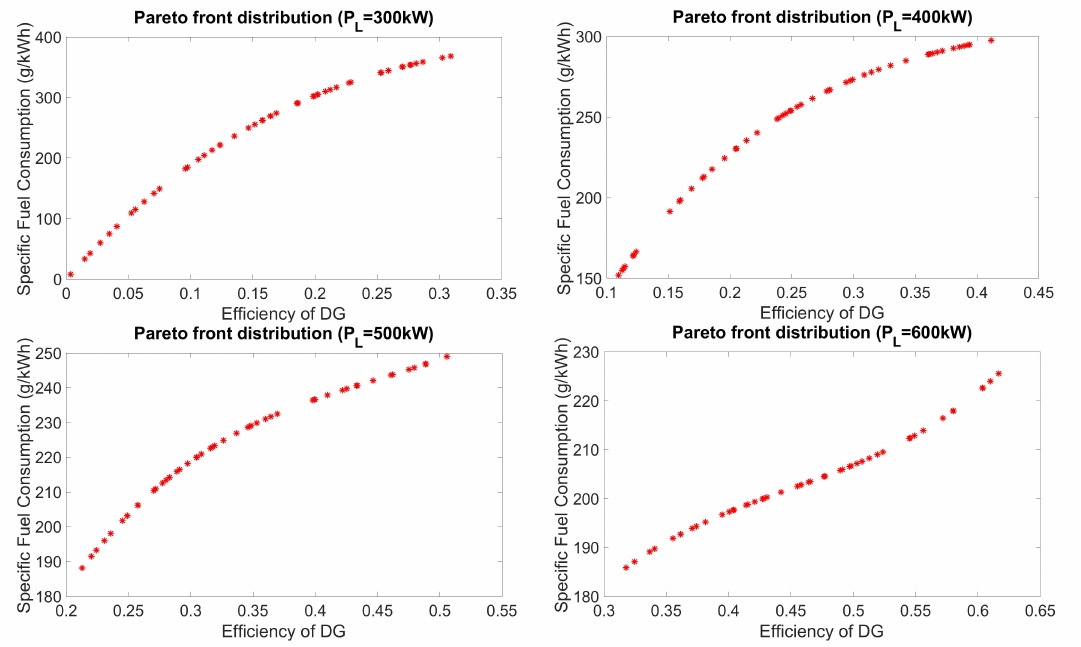
Figure 4. The distribution of non-inferior solutions for ships with di ff erent power